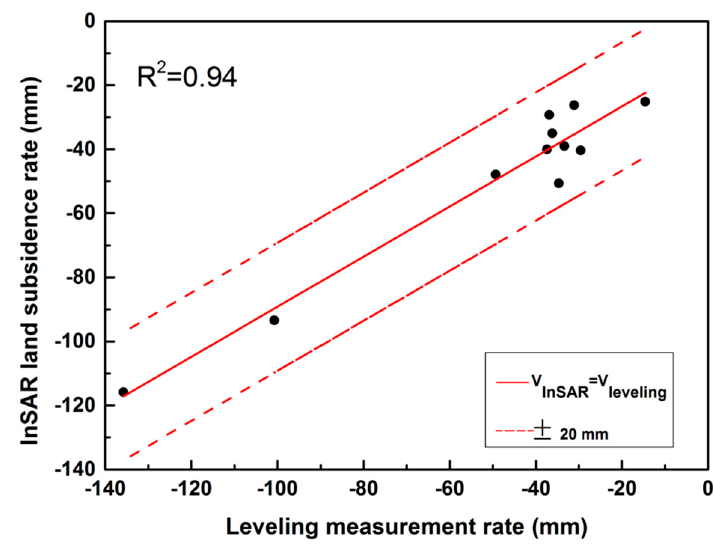
Figure 2. The comparison of land subsidence rates derived from the Persistent Scatterer Interferometric Synthetic Aperture Radar (PSI) technique and from leveling measurements rates. The location of benchmarks are shown in Figure 1.